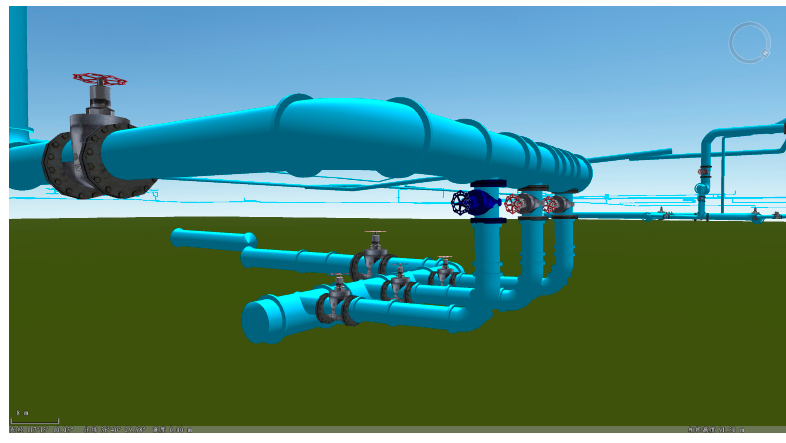
Figure 10. The adaptive rendering map in 3D GIS.